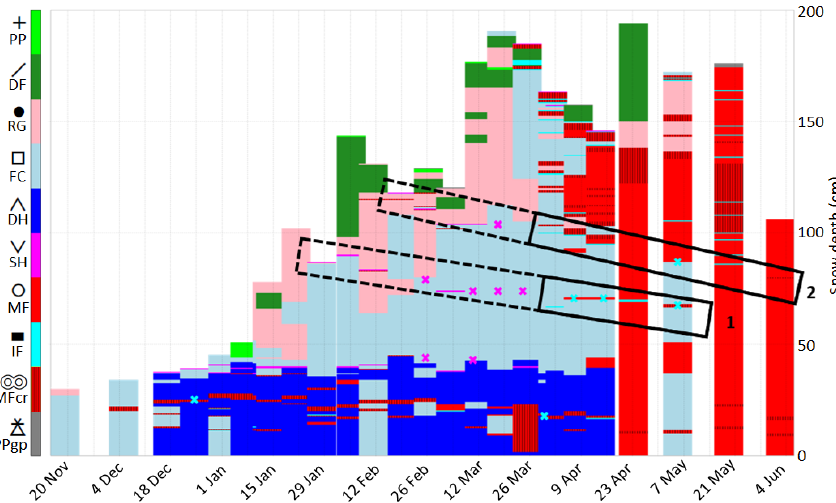
Figure 3. Visual observations of grain shapes at WFJ during winter 2017. Colors, symbols and codes are defined following the grain shape classification of Fierz et al. (2009), fuchsia crosses represent surface hoar as secondary grain shape, and cyan crosses represent ice lenses. Rectangles highlight layers 1 and 2 with dashed lines before ice formation and solid lines afterwards.